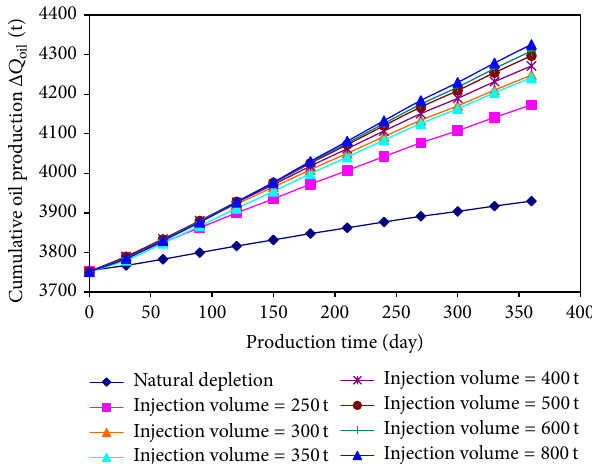
Figure 9: Cumulative oil production at different injection volumes.